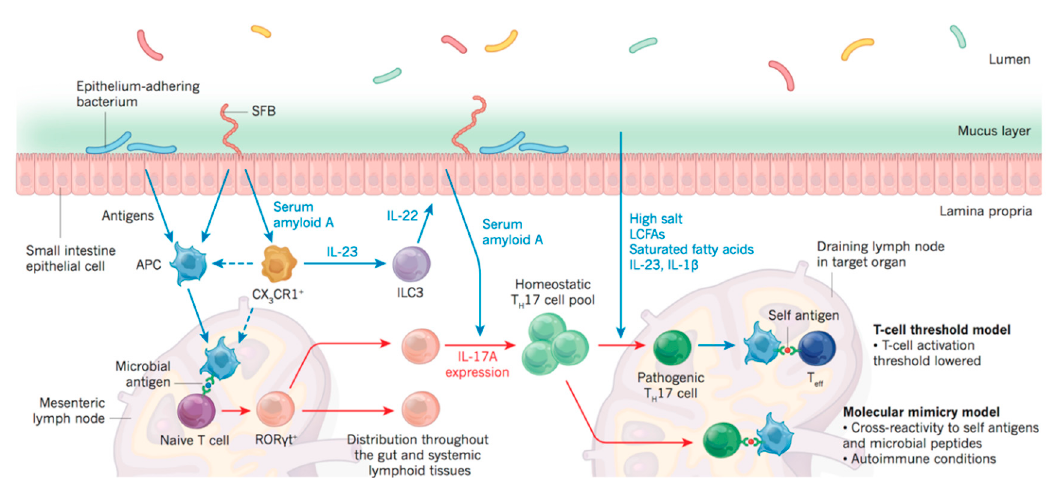
Figure 3. Microbiome and Th17 autoimmunity. Research in intestinal mucosal microbiome has revealed a link with Th17 response and epithelial integrity. These studies may provide useful hints to researchers working on other mucosal linings. Furthermore, direct links between the intestinal microbiota and ocular diseases have been suggested, including a link with uveitis [50], and dry eye disease [49]. Figure taken from Kenya Honda et al. [51] with permission.